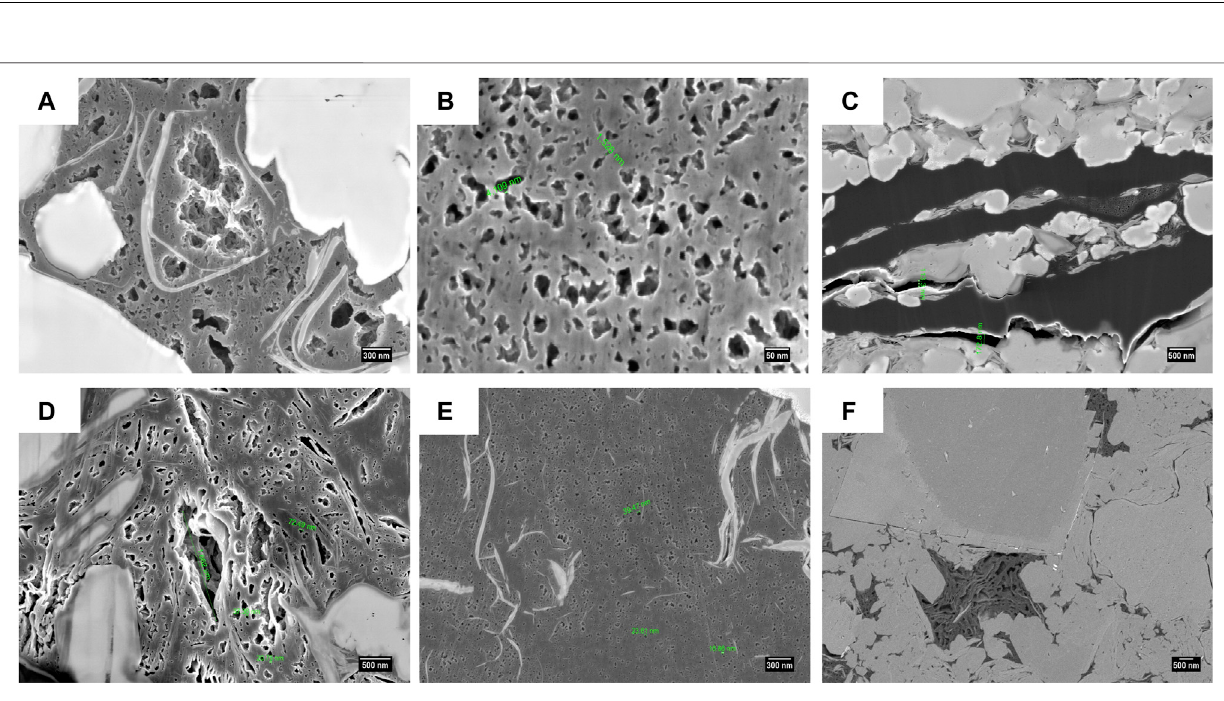
Frontiers in Earth Science |